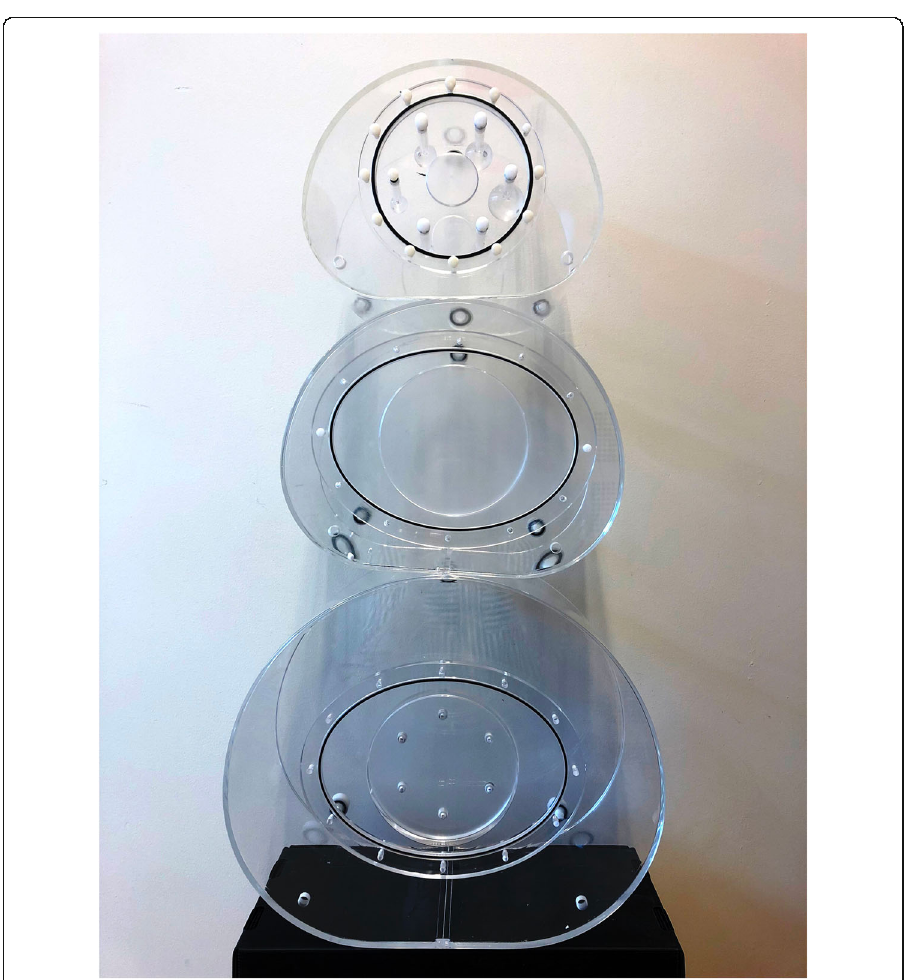
Fig. 1 The phantoms used to determine the RC. Upper phantom: NEMA IEC body phantom. Lower two phantoms: custom-made phantoms reflecting a larger body mass index (BMI, kg/m 2 ) of patients. Note that the lower two phantoms are depicted without spheres